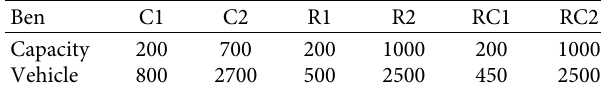
Table 6: The data of the vehicles.